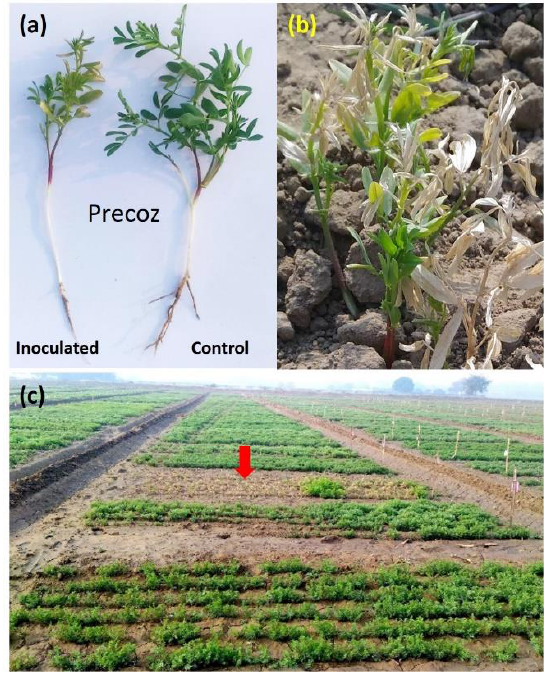
Figure 1. Lentil genotype Precoz that was infected with R. bataticola . ( a ) Infected and control seedling, ( b ) Infected seedlings showing wilting symptoms, ( c ) Infection under field conditions where red arrow indicates a dried patch of lentil crop due to the R. bataticola infection under field conditions.